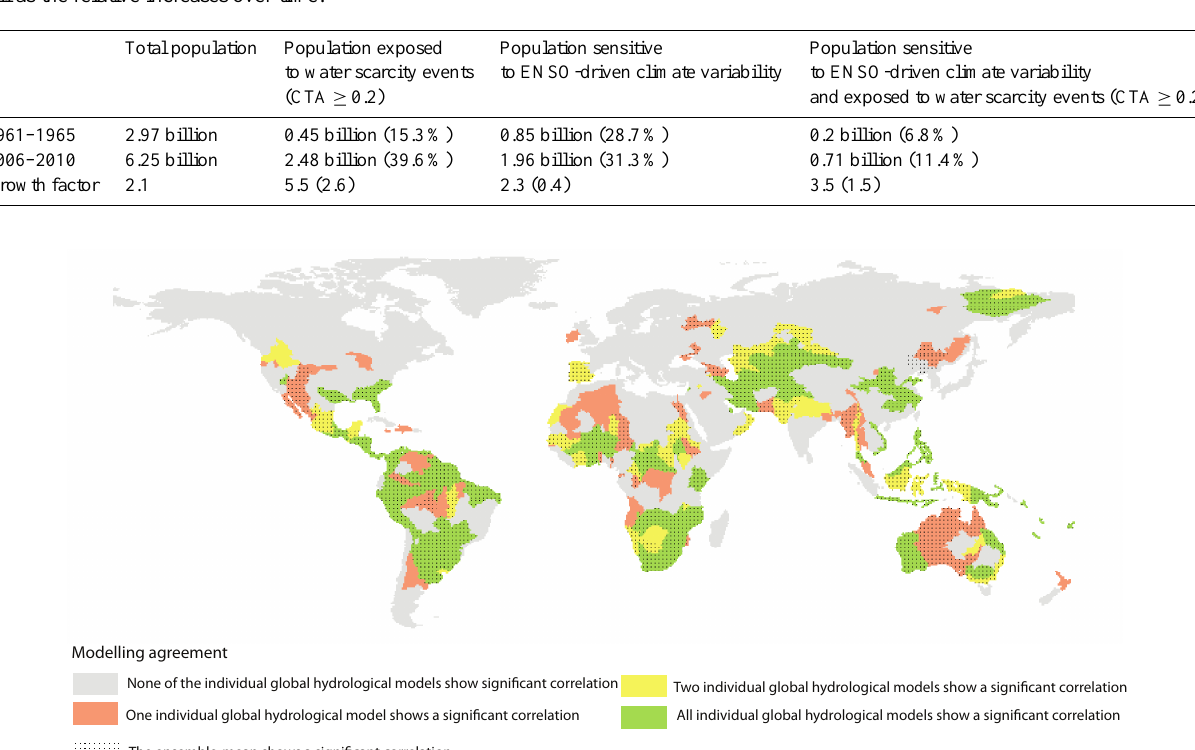
Figure 6. Modelling agreement in observed significant sensitivity of water availability to variation in JMA